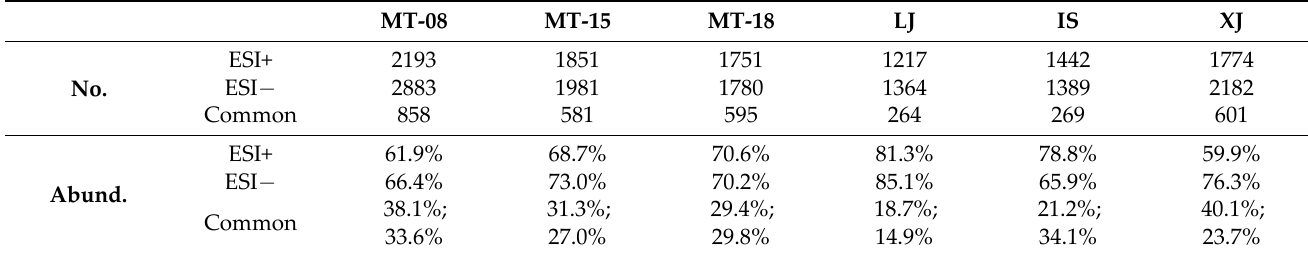
Table 2. Number and relative abundance of molecular formulas detected from different samples by ESI+ and ESI − mass spectrometry.